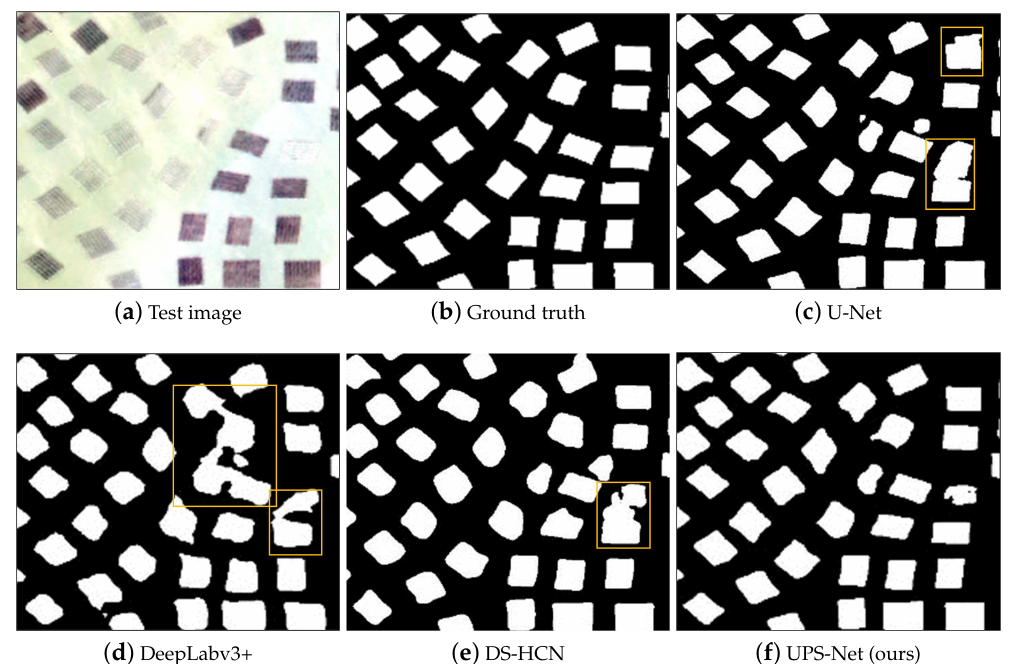
Figure 10. The ‘adhesion’ phenomenon in the result maps of raft aquaculture areas extraction: ( a ) Test image; ( b ) Ground truth; ( c ) U-Net; ( d ) DeepLabv3+; ( e ) DS-HCN; ( f ) UPS-Net. The yellow rectangles indicate that raft aquaculture areas appeared ‘adhesion’